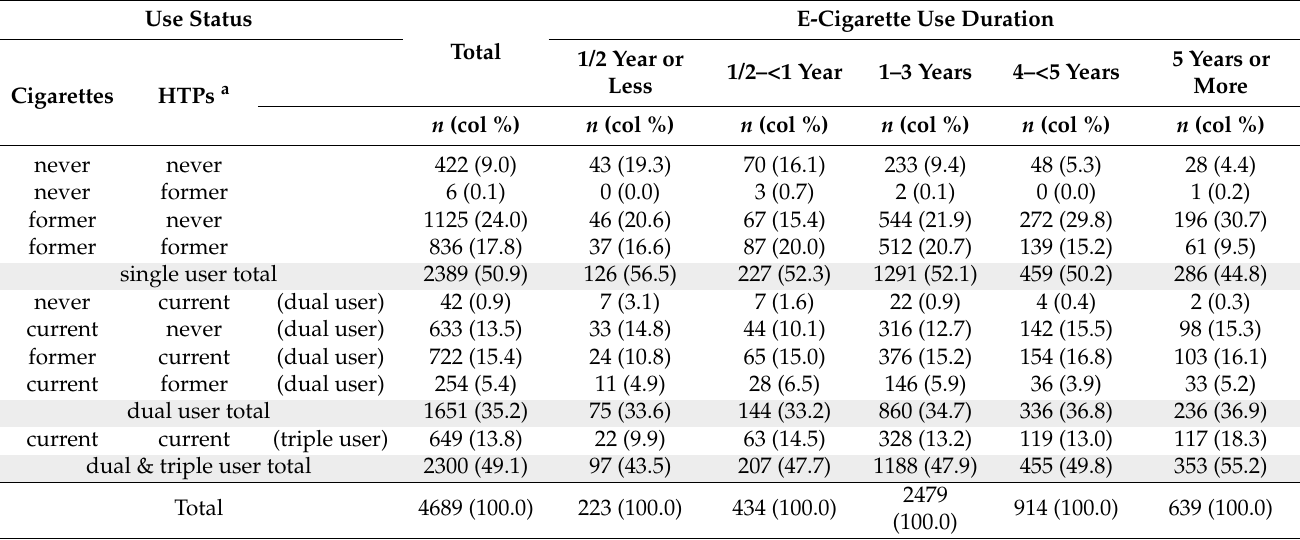
Table 3. Use status of tobacco (cigarettes and heated tobacco products) according to e-cigarette use duration ( n =